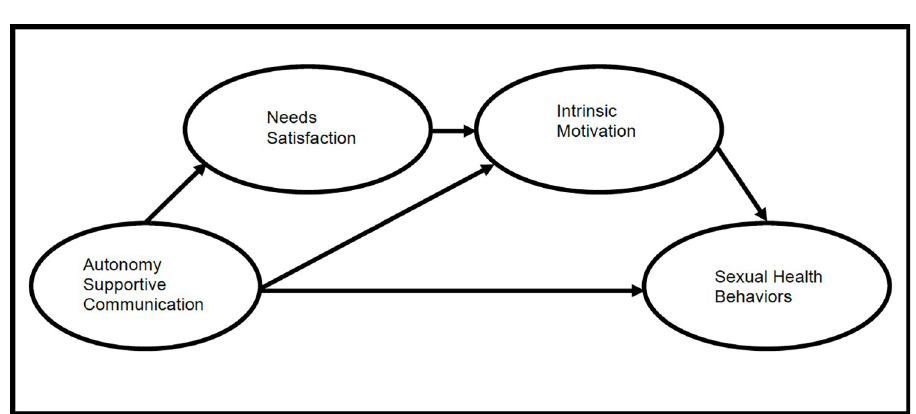
Fig 1. Hypothesized SEM for direct and indirect effects of predictor variables on sexual health behaviors.